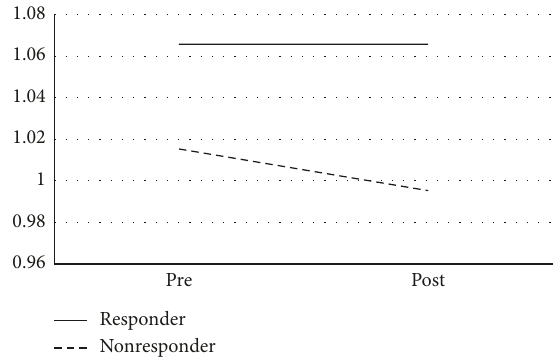
Figure 5: Changes in prefrontal cortex volume. The figure shows changes in total gray matter volume (mm 3 plement group “responders” and